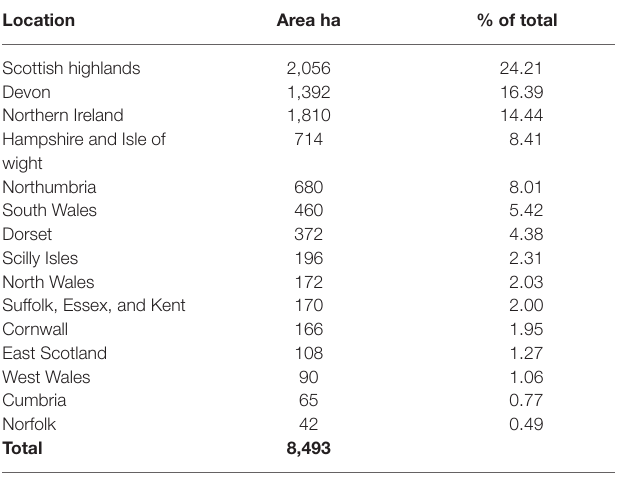
TABLE 2 | Distribution of contemporary mapped seagrass area from the OSPAR and Water Framework Directive datasets, and other collected data sources since 1998.